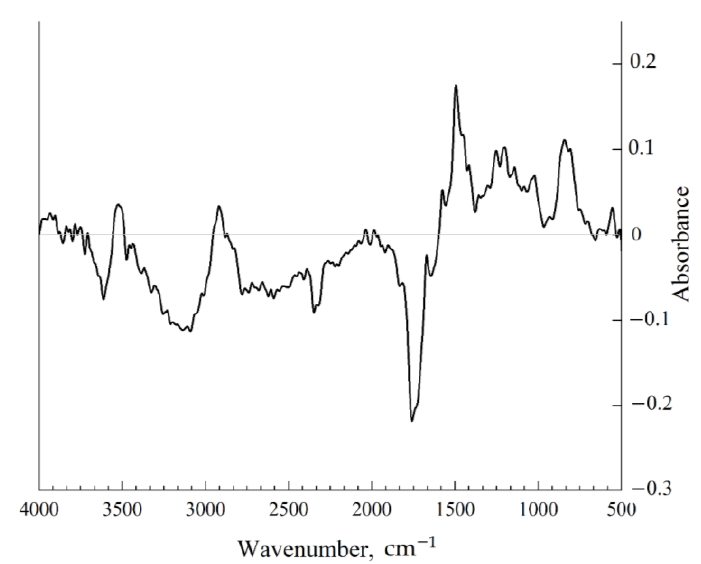
Figure 6. Difference spectrum of samples stored inside and attached to the test wall. Samples charred at 450 °C.